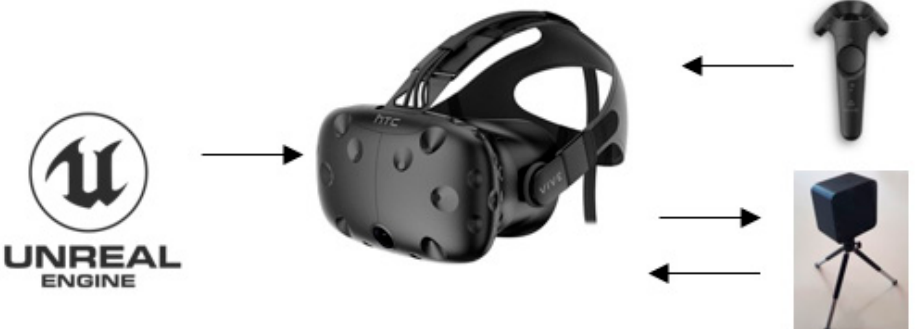
Figure 1. Scheme of immersive virtual reality components.